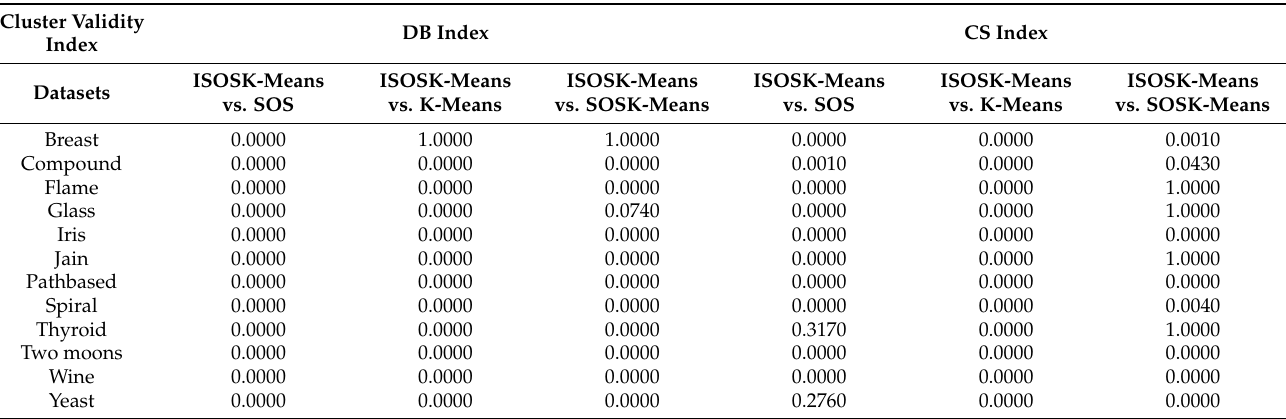
Table 12. Wilcoxon signed-rank test for ISOSK-means, SOSK-means, SOS, and